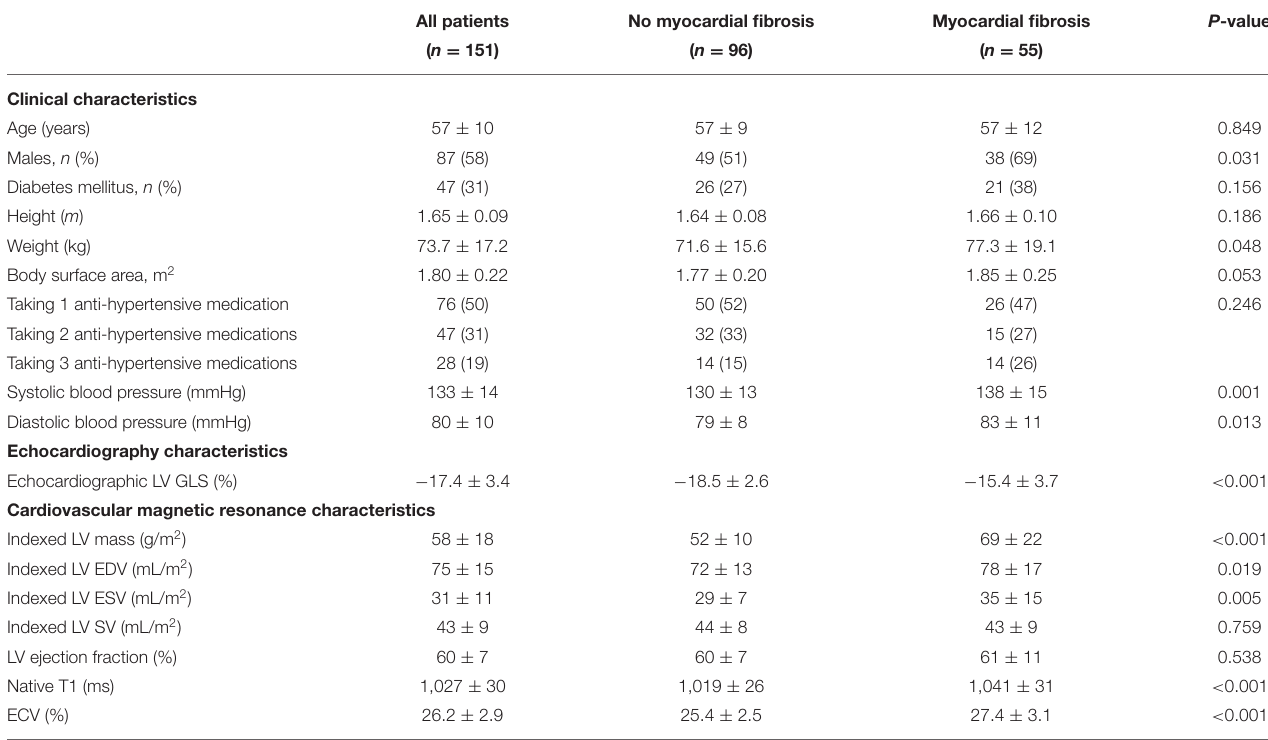
TABLE 1 | Characteristics of patients in the derivation cohort.